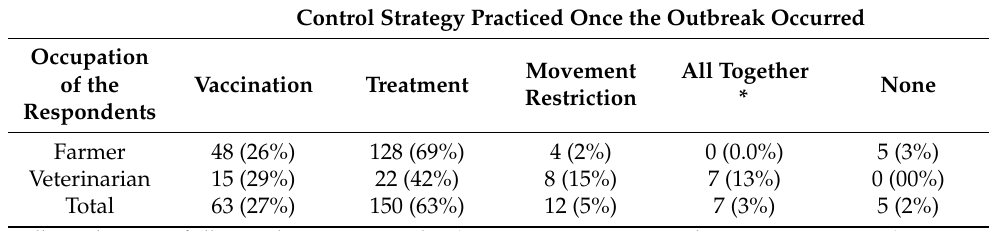
Table 3. Occupation of the respondents and their control strategy applied (2018 to 2020) ( N =